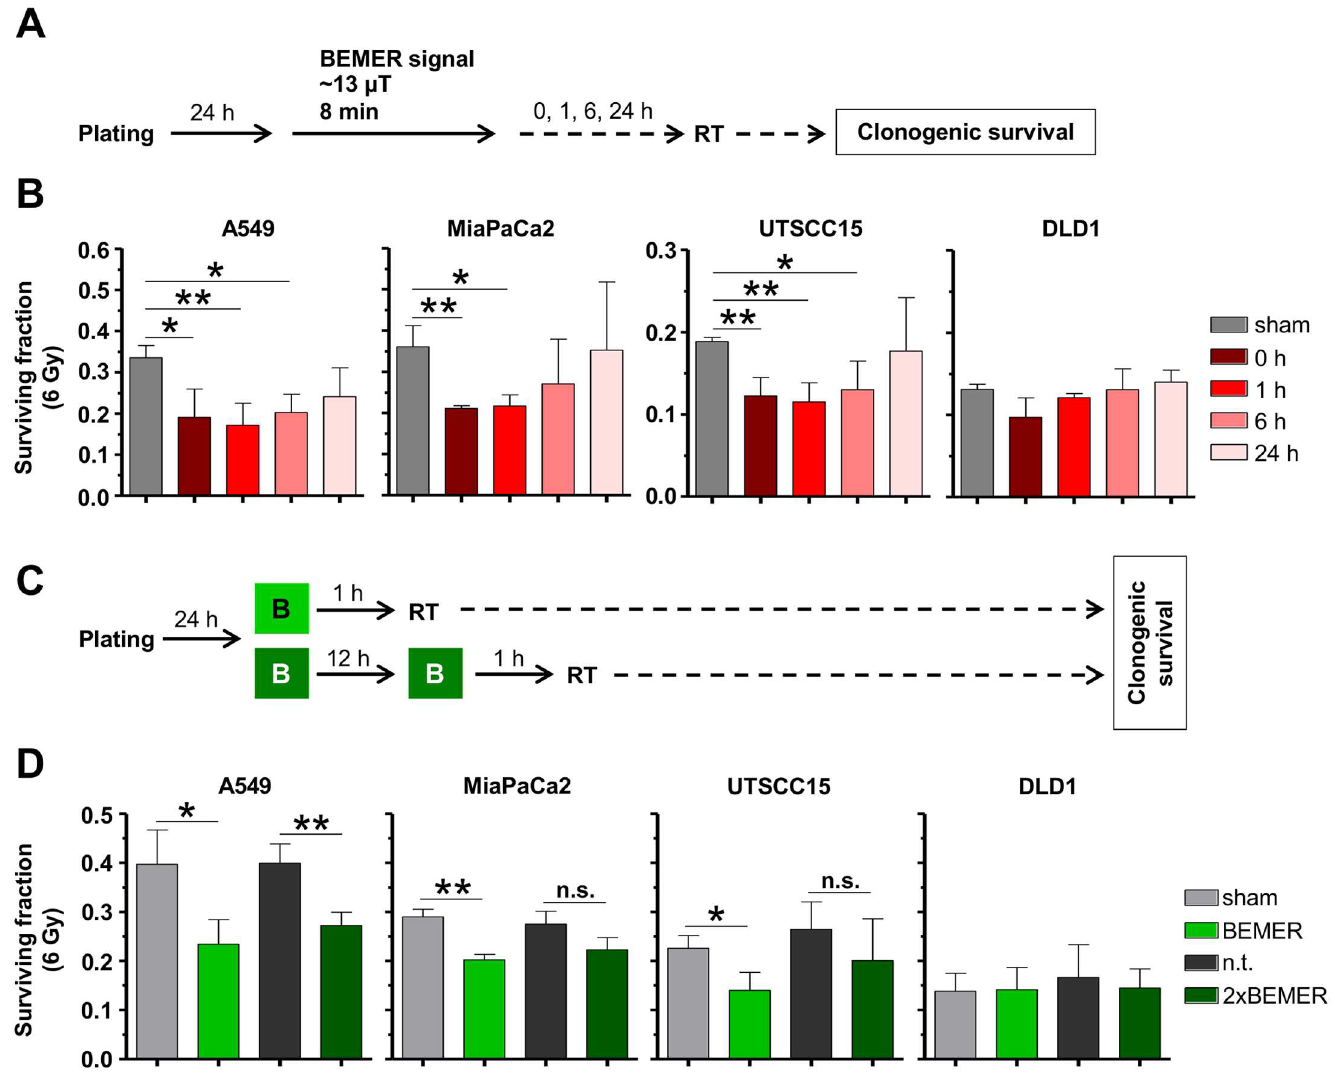
Fig 5. BEMER therapy-mediated radiosensitization depends on treatment intervals and frequency. (A) Flow chart of colony formation assay. (B) Clonogenic survival after BEMER therapy (~13 μ T, 8 min) combinedwith 6-Gy irradiationof indicatedcell lines. BEMER sham-treated (sham) and irradiatedcells served as control. Time intervalsof 0, 1, 6, and 24 h betweenBEMER therapy and radiotherapy were applied.(C) Flow chart of colony formation assay. (D) Clonogenic survival of one time or two time BEMER therapy (~13 μ T, 8 min) combinedwith 6-Gy irradiationof indicatedcell lines (BEMER sham-treated (sham), irradiatedcells as control). All results representmean ± SD. Student’s t-test. n = 3. * P < 0.05; ** P < 0.01. n.s., not